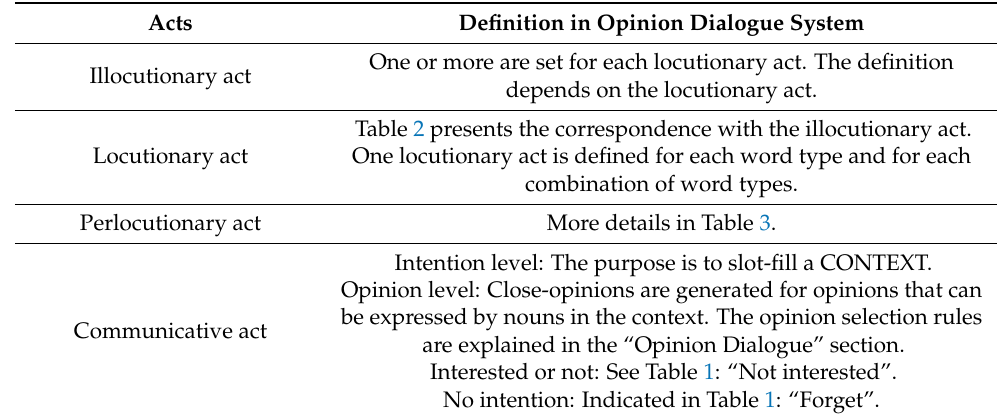
Table 4. Communicative acts and opinion dialogue system responses.